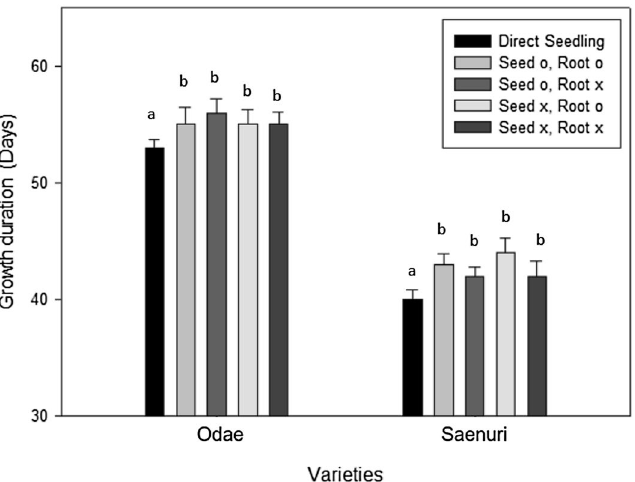
Figure 7. The growth duration under cutting (x) and noncutting (o) conditions for rice seeds and roots using 7-day-old seedlings. The roots were cut up to 1.5 cm in length. Significant differences were evaluated using Duncan’s multiple range test at the 5% level. Error bars are standard deviations.